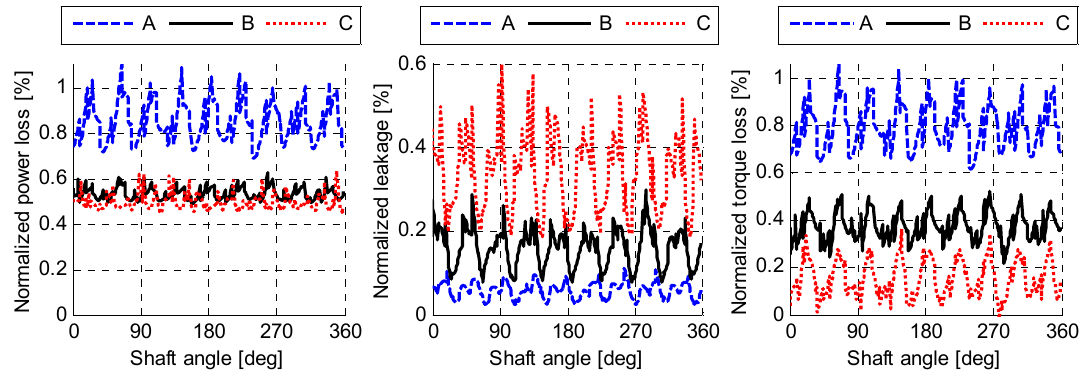
Figure 6. Normalized piston/cylinder performance for different sizes.